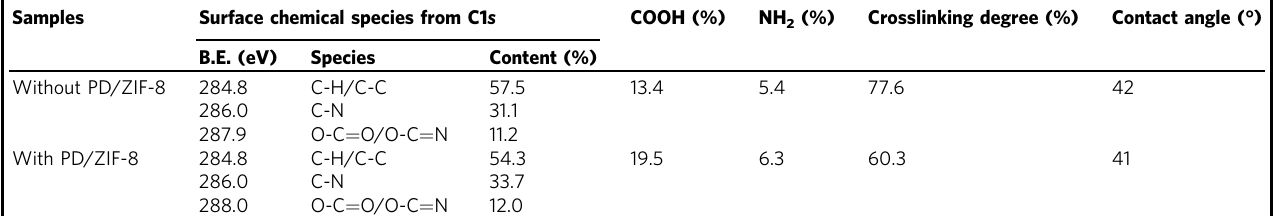
Table 1 Surface chemical components of PA NF membranes prepared from SWCNTs/PES composite membrane with and without PD/ZIF-8 nanoparticles loading